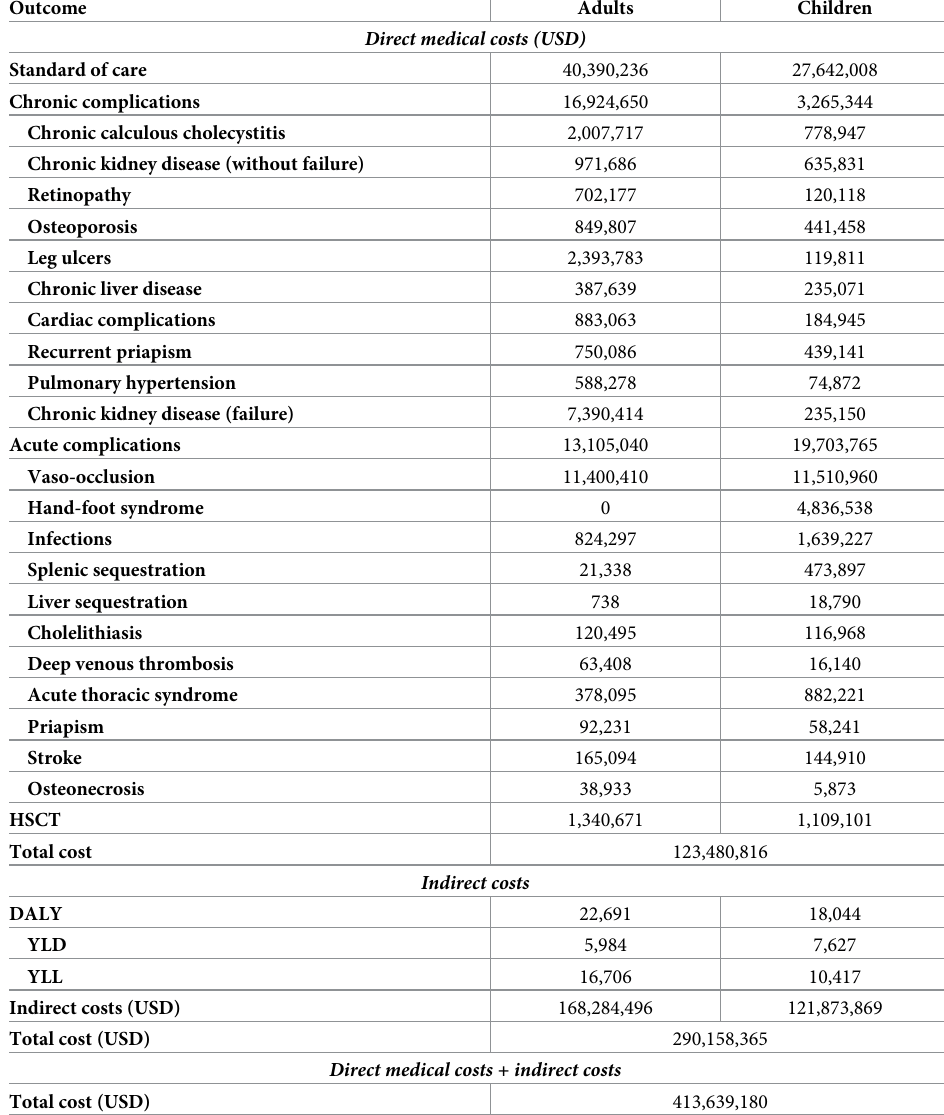
Table 4. Disease